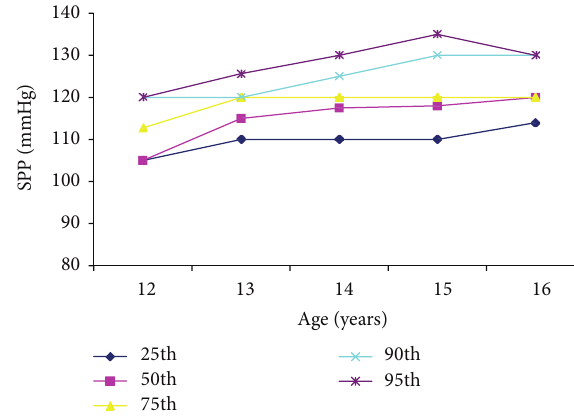
Figure 1: Percentile distribution of systolic blood pressure.